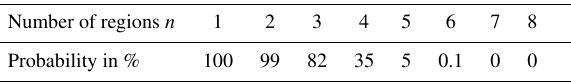
Table 2. Probability that blue matrix elements in Fig. 8 dominate in n regions by chance. Half of the elements are colored blue and red, respectively, and eight white elements are randomly added subse-